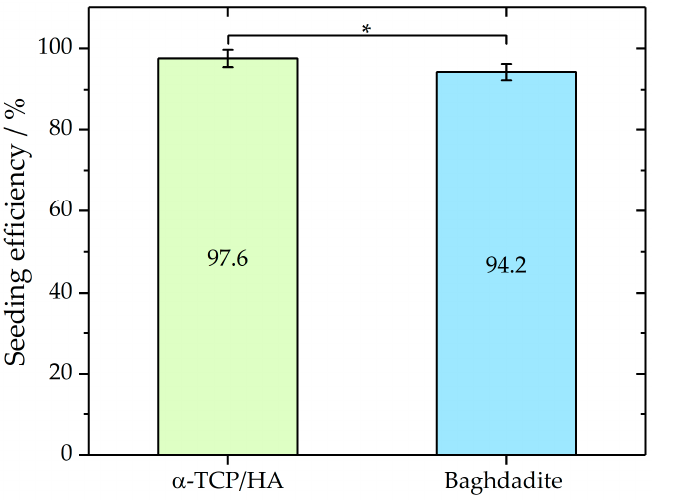
Figure 2. Seeding efficiencies of MC3T3-E1 in α -TCP ( n = 9) and baghdadite ( n = 7) scaffolds as mean with standard deviation. Mann–Whitney test p < 0.05; Z = 1.87. Seeding volume of the cell suspension was 80% of the total pore volume of each scaffold type. * p < 0.05.